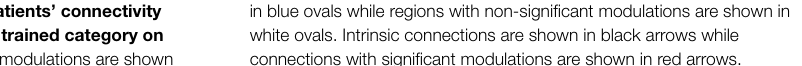
in blue ovals while regions with non-significant modulations are shown in white ovals. Intrinsic connections are shown in black arrows while connections with significant modulations are shown in red